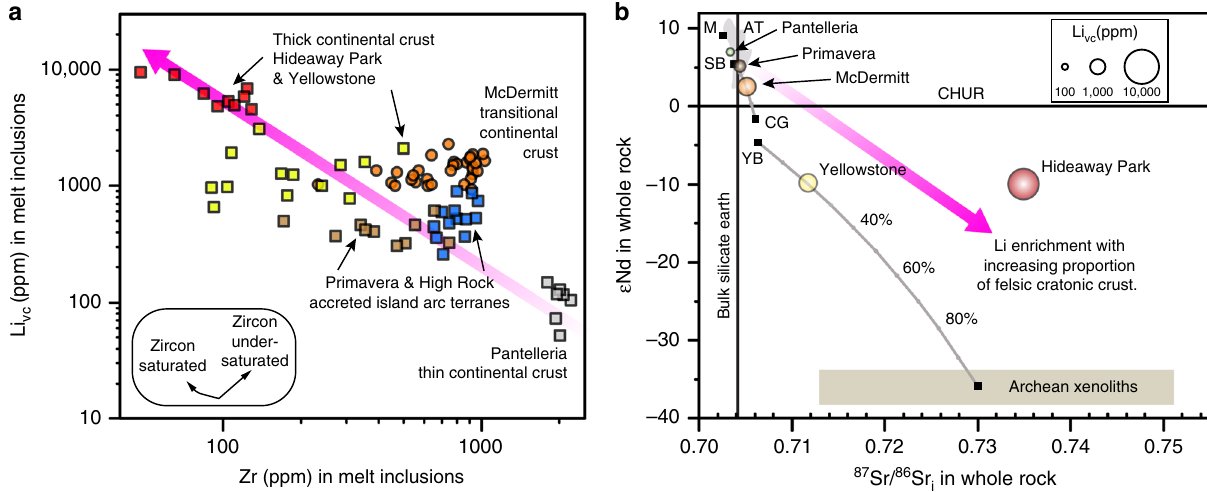
Fig. 4 Li enrichment as a function of amount of felsic crustal material incorporated in the rhyolitic magma. a Li concentration (Li vc , corrected for vapor loss) vs. Zr in melt inclusions. Li is highest in magmas in intracontinental settings that assimilate thick felsic crust. Inset box illustrates expected trends with increasing differentiation in the presence of zircon and in its absence. b Whole-rock ε Nd vs. 87 Sr/ 86 Sr i of rhyolites with possible components ( M : depleted mantle, AT : fi eld for accreted island arc terranes, SB : Steens basalt, YB : Yellowstone basalt, CG : Cretaceous granite of the Santa Rosa Range, Nevada). The sizes of rhyolite data points correspond to average Li vc in melt inclusions. Simple isotopic mixing curves ( gray lines ) for Yellowstone and McDermitt demonstrate that these moderately Li-enriched magmas incorporated ~10% and ~50% felsic crust, respectively. Isotopic and concentration values and data sources appear in Supplementary Data 1 and